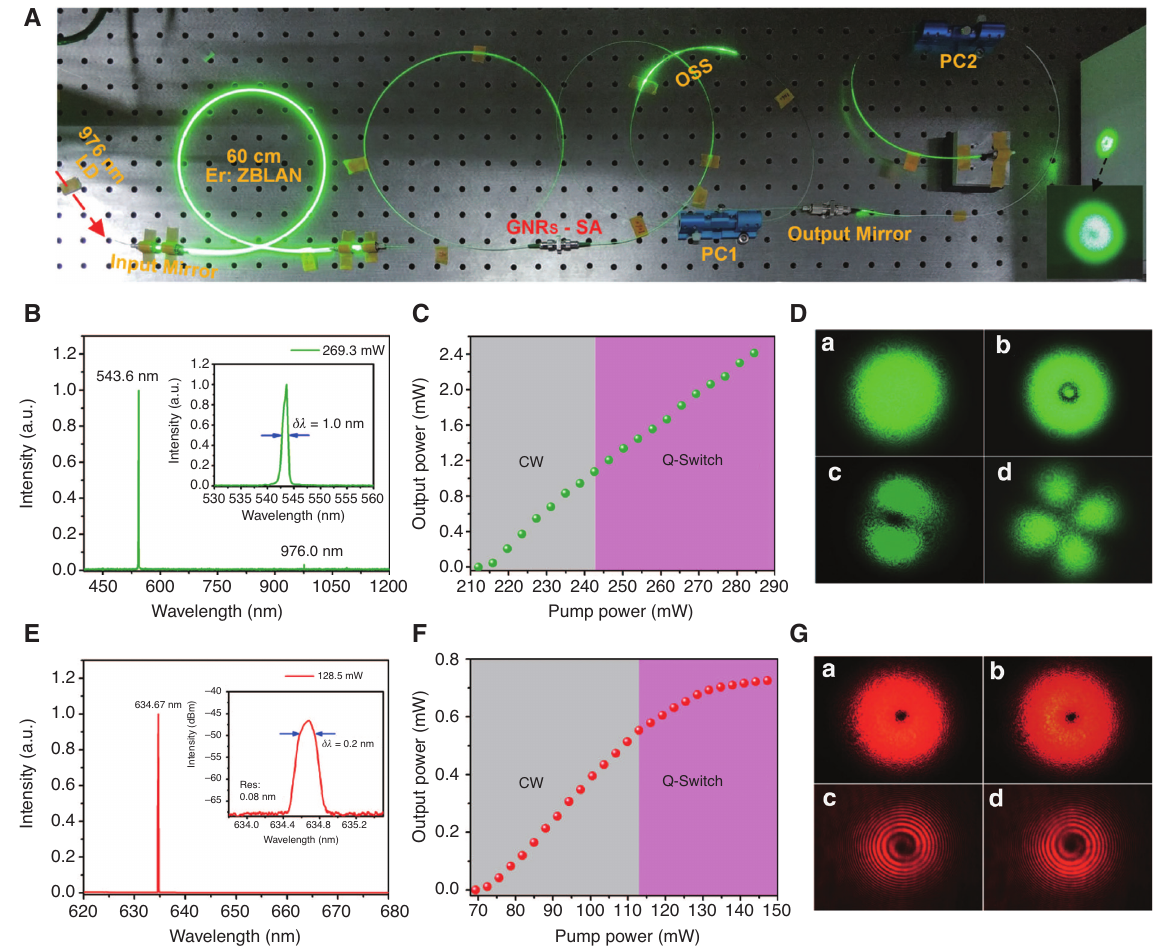
Figure 9: Visible Q-switched vortex-beam oscillations in an all-fiber laser based on a Au NR SA. (A) Photograph of the green vortex laser. (B) Optical spectrum of the green vortex laser. (C) Output power of the green vortex laser. (D) Near-field intensity distributions of the high-order modes: (a) LP vortex laser. (F) Output power of the red vortex laser. (G) CCD images of the pulsed vortex beams: (a), (b) intensity profiles of OAM (c),(d) the corresponding spiral interferograms. (A–G) Reprinted from Ref. [144], Copyright 2019, Royal Society of